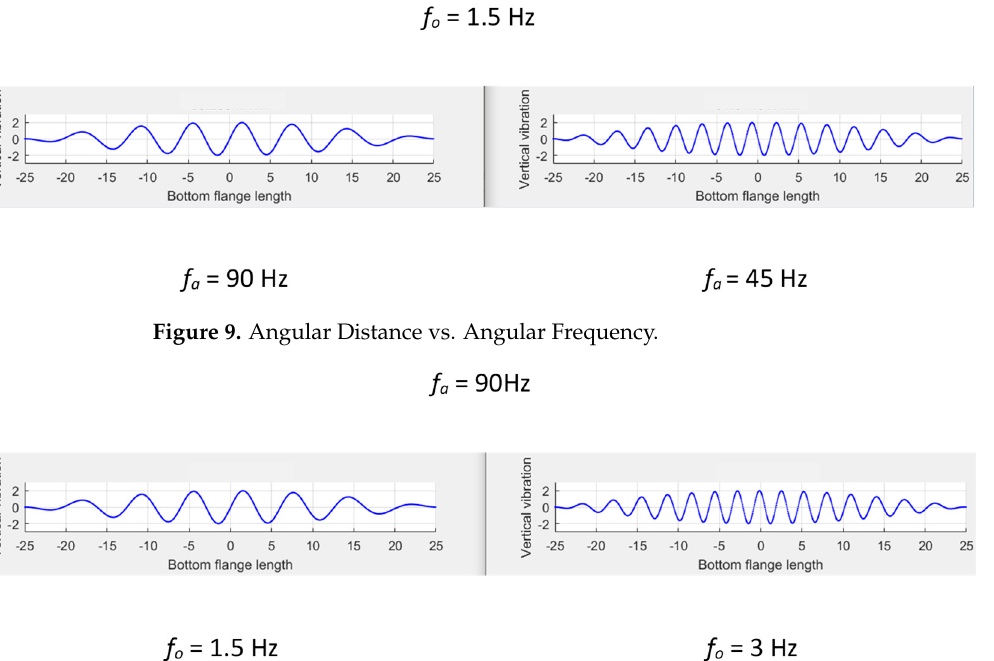
Figure 10. Angular Distance vs. Vibration Frequency.